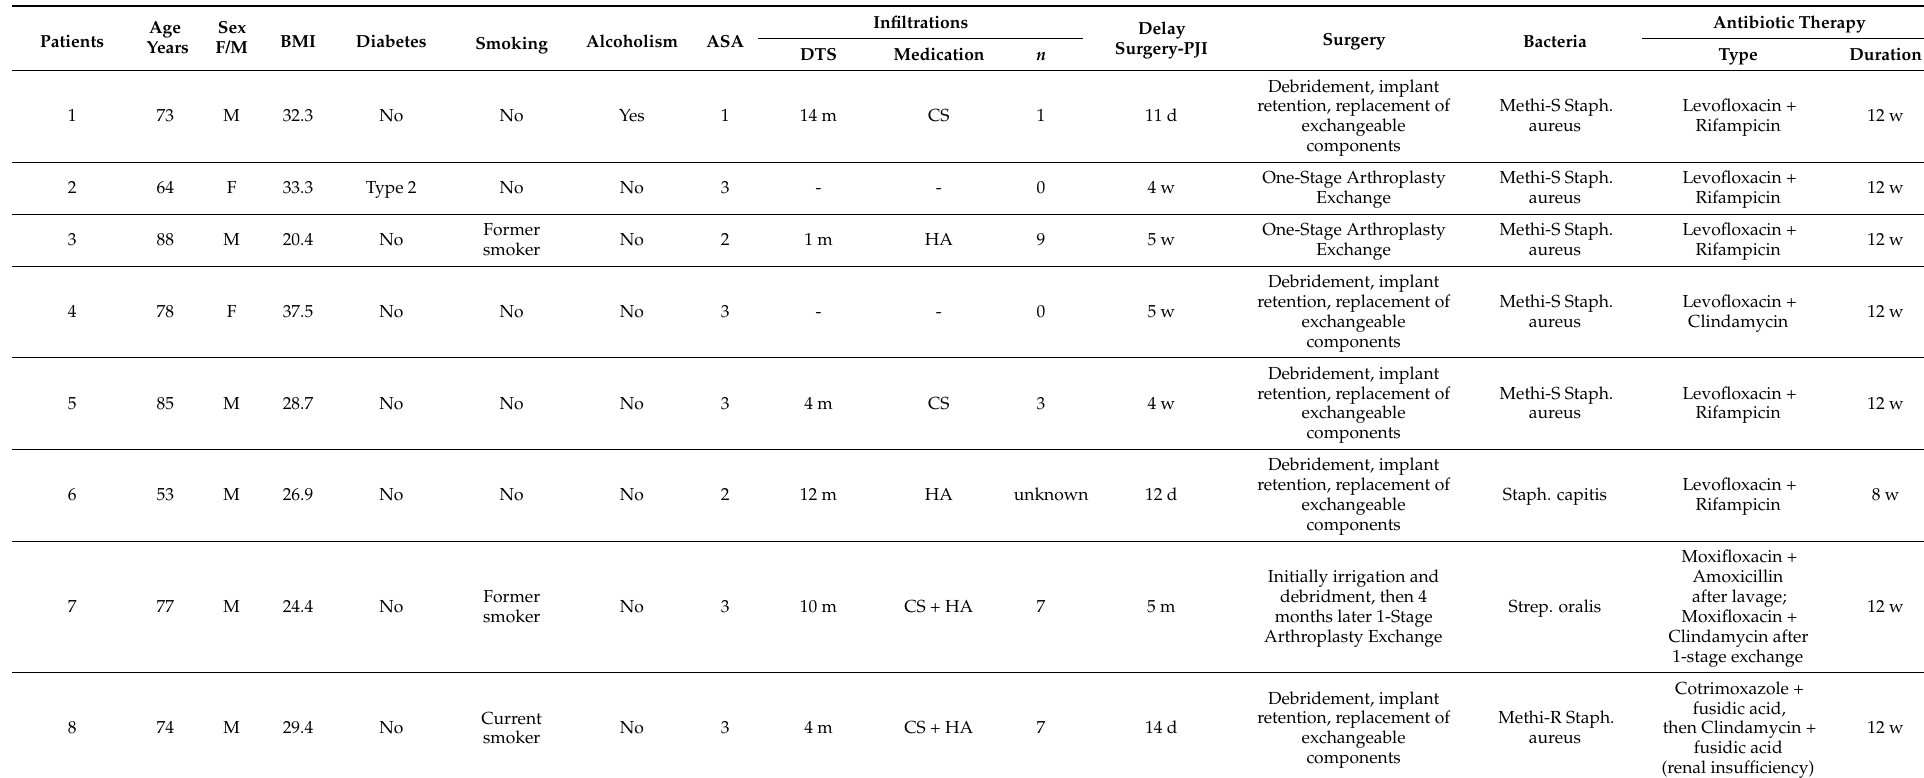
Table 2. Cases of periprosthetic joint